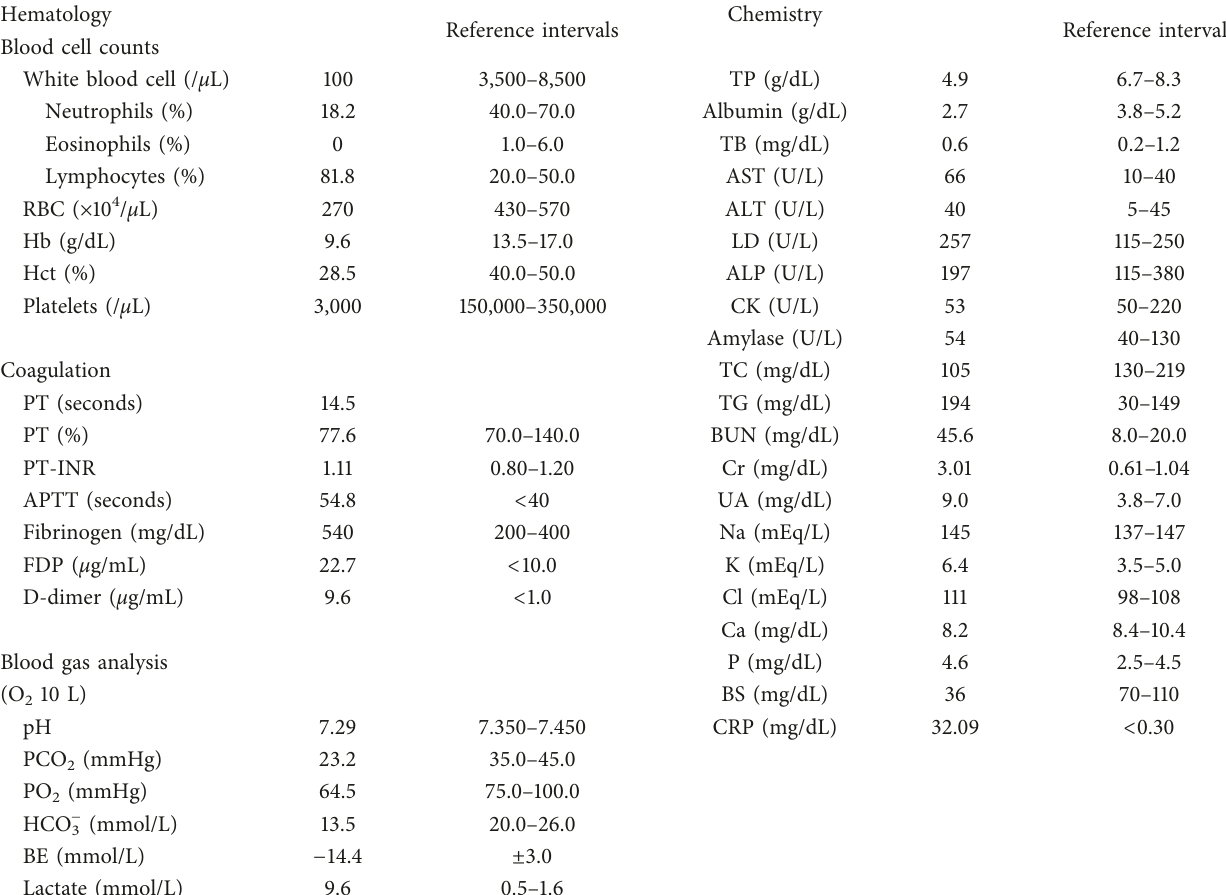
Table 1: Results of the laboratory